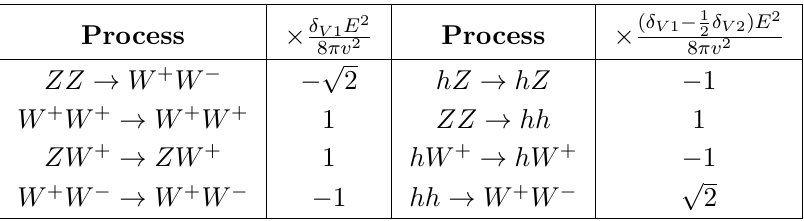
Table 1 . 4-body model-independent unitarity-violating process from modifications to the Higgs coupling to W/Z bosons. The left-hand side amplitudes are model-independent since they only depend on δ while the ones on right-hand side depend on δ V 1